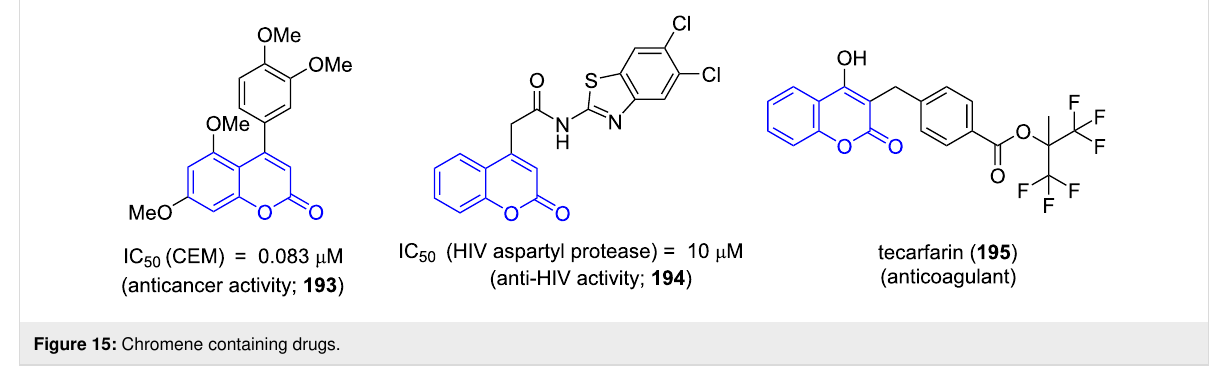
Figure 15: Chromene containing